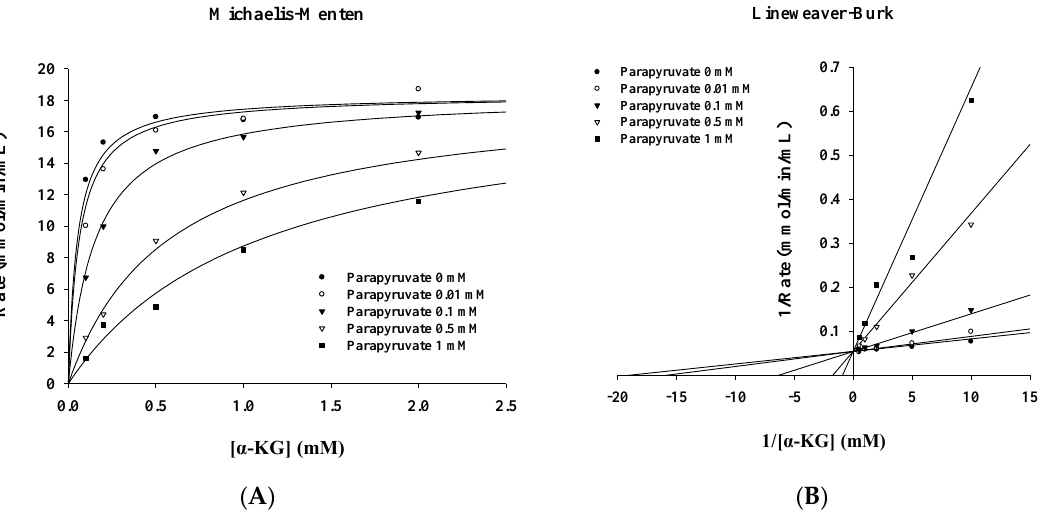
Figure 2. The inhibition kinetics of parapyruvate on the KGDHC. ( A ) Michaelis Menten plot. ( B ) Lineweaver–Burk plot. Table 3. Kinetic parameters of the KGDHC inhibition by the parapyruvate.